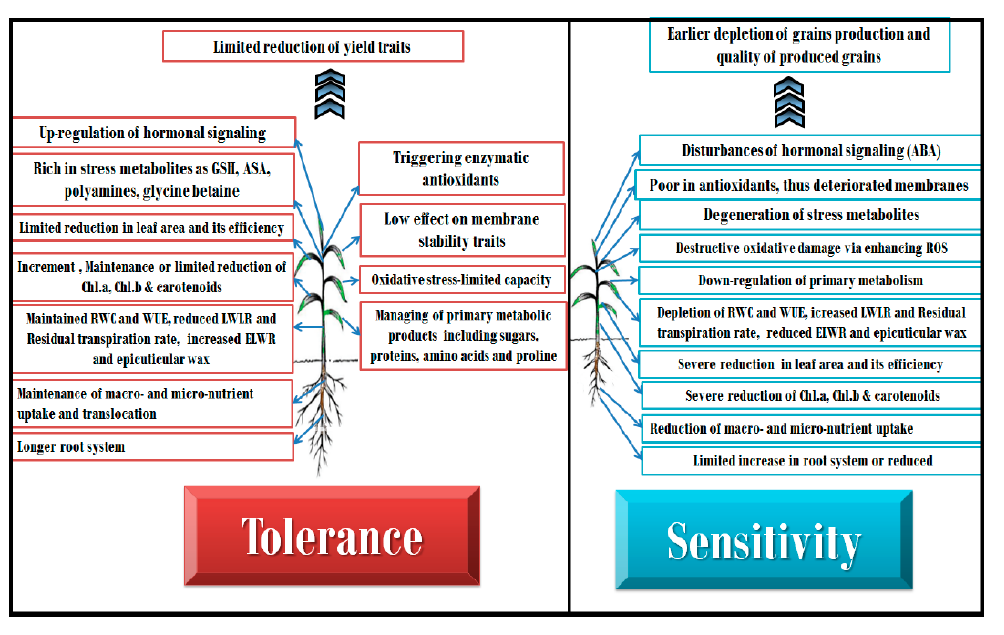
Figure 1. Physiological changes in tolerant and susceptible wheat and barley genotypes in response to drought